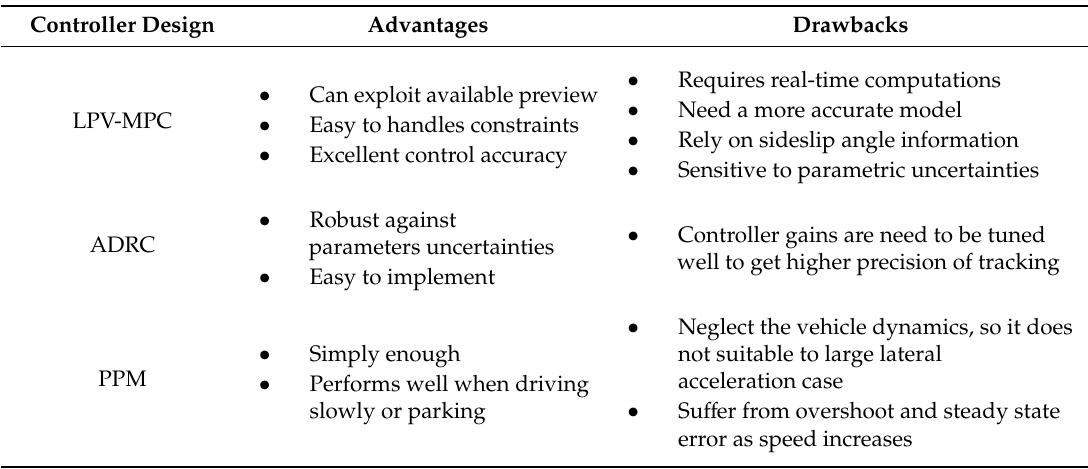
Table 3. Comparison of the lateral control